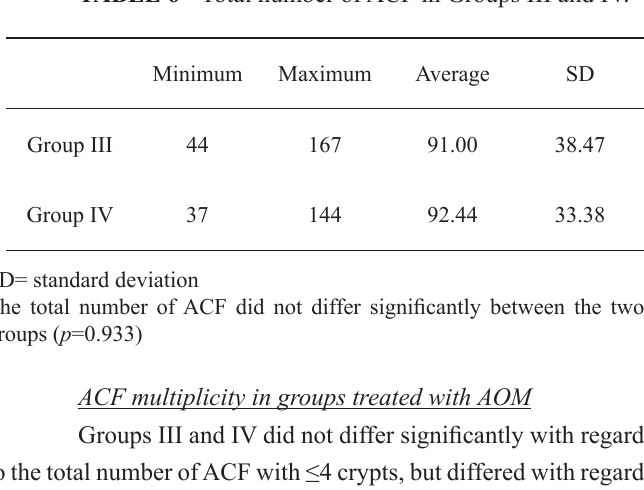
TABLE 6 - Total number of ACF in Groups III and